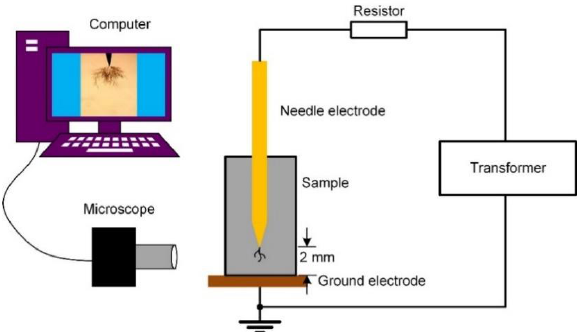
Figure 1. Treeing experiment setup.